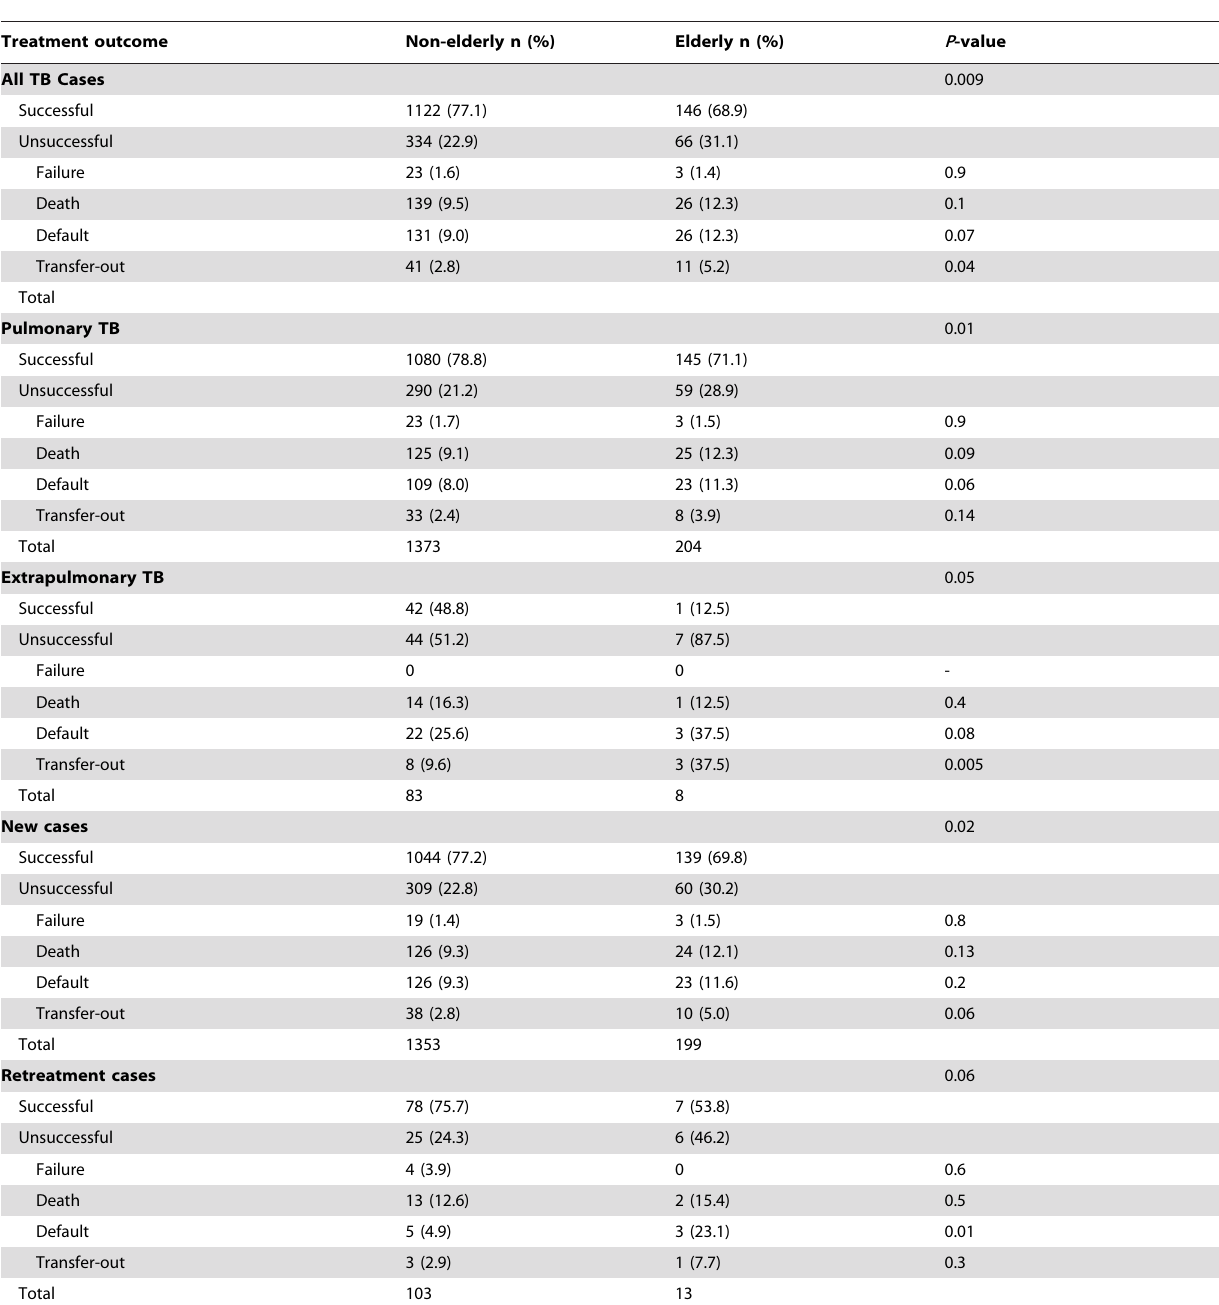
Table 2. Treatment outcomes stratified by type of TB and treatment category in Nigeria, 2011–2012.